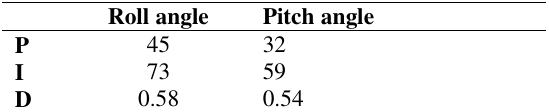
Optimized Parameters of simulated model